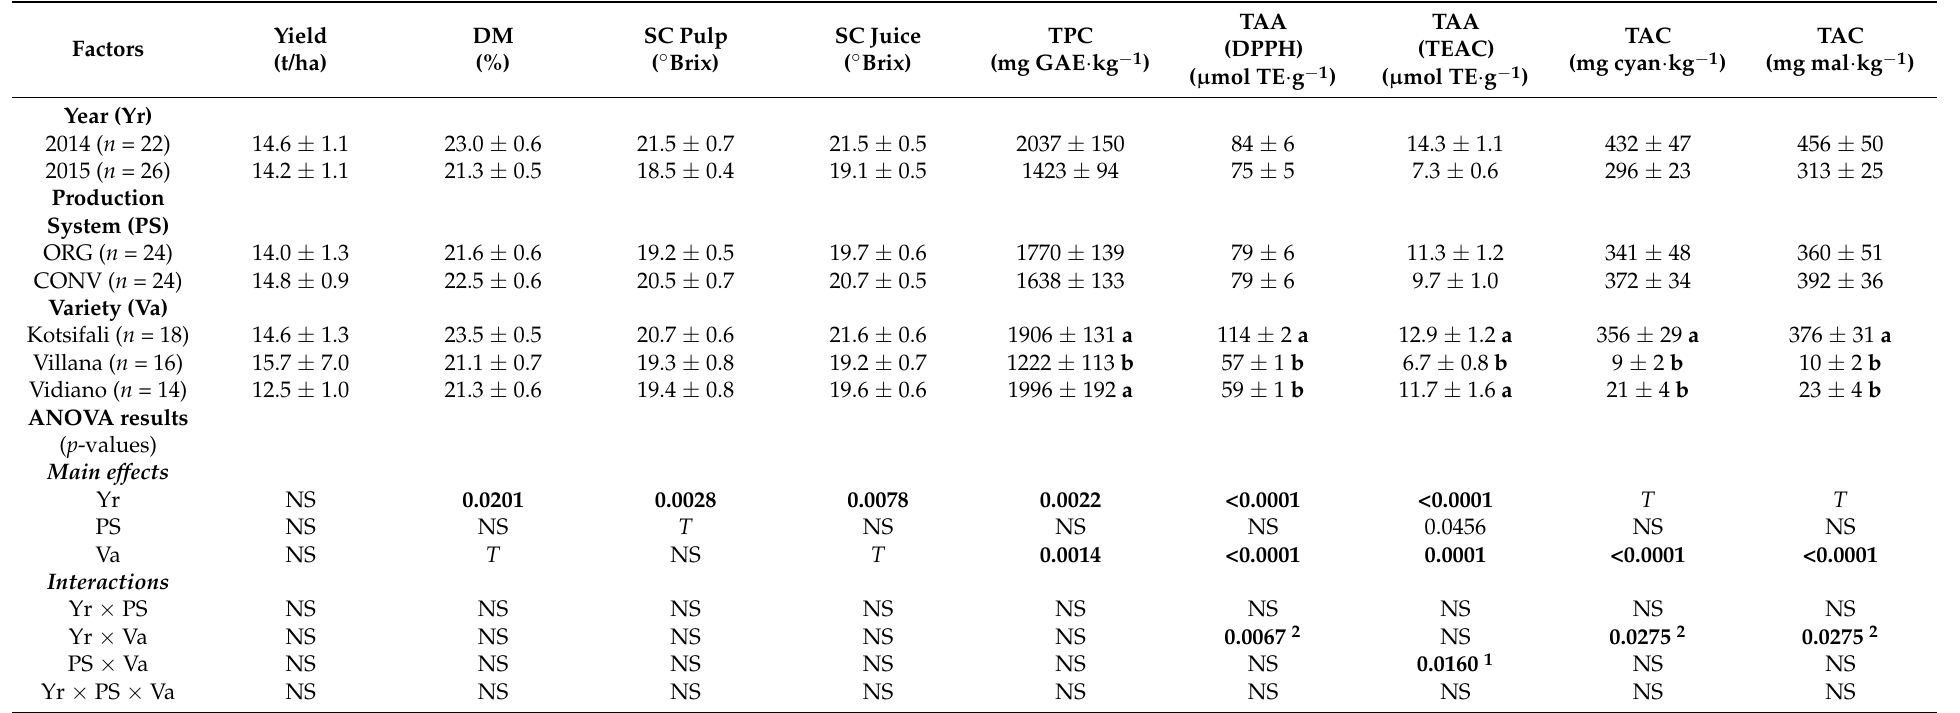
Table 1. Effect of, and interaction among, production system (organic (ORG) vs. conventional (CONV)), variety, and year for the yield, dry matter content (DM), sugar content (SC) of pulp/juice, total phenolic content (TPC), total antioxidant activity (TAA) using the 2,2-diphenyl-1-picrylhydrazyl (DPPH) or Trolox Equivalent Antioxidant Capacity (TEAC (assays and total anthocyanin content (TAC) (expressed as cyanidin-3- O -glucoside (cyan) and malvidin-3- O -glucoside (mal) equivalents) in table grapes of the Cretan local varieties Kotsifali, Villana, and Vidiano (three-factor ANOVA). TE, Trolox